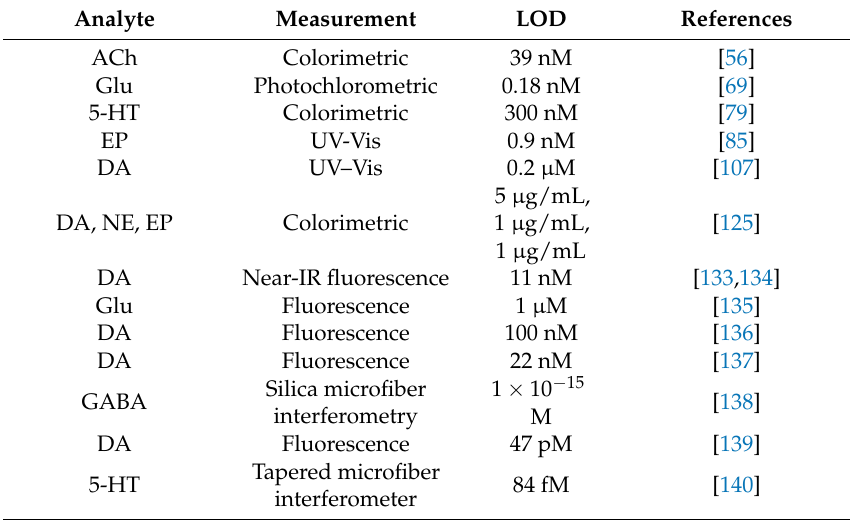
Table 7. Summary of recently published neurotransmitter sensors based on optical sensing